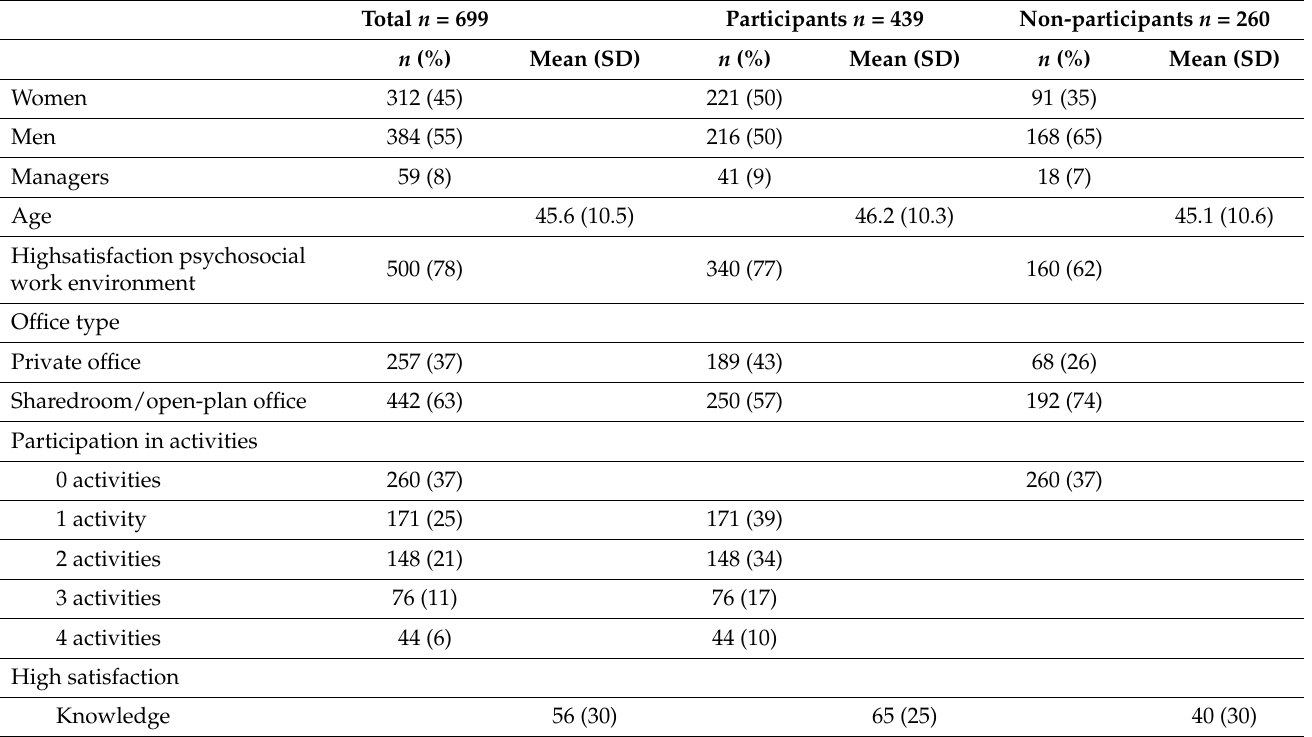
Table 1. Descriptive data at baseline for employees participating and not participating in activities; sex, age, manager, office type, number of activities attended, and satisfaction with knowledge, office rules, information and